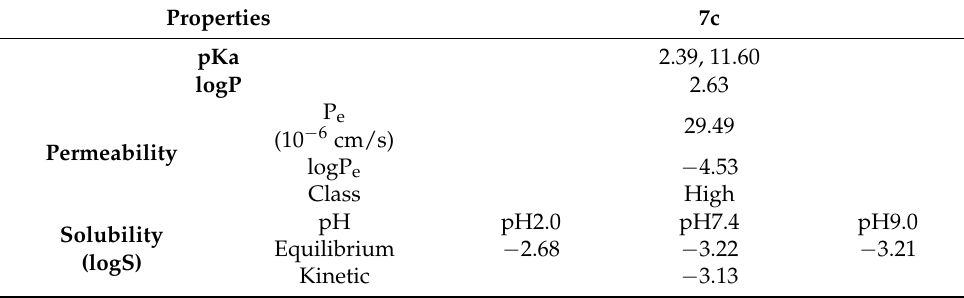
Table 4. Physicochemical Properties of the Lead Compounds 7c